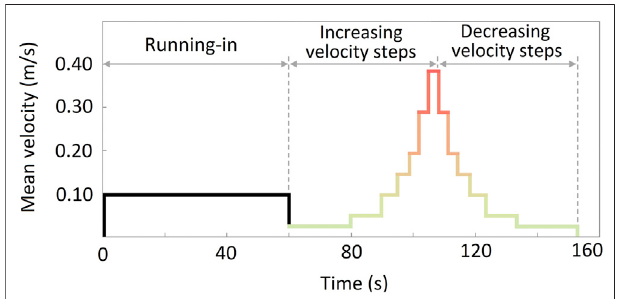
FIGURE 8 | Change of sliding velocities during each experiment performed on the oscillating tribometer. Tests were carried out at different velocities, fi rst at increasing and afterward at decreasing velocity, to analyze the in fl uence of both types of motion